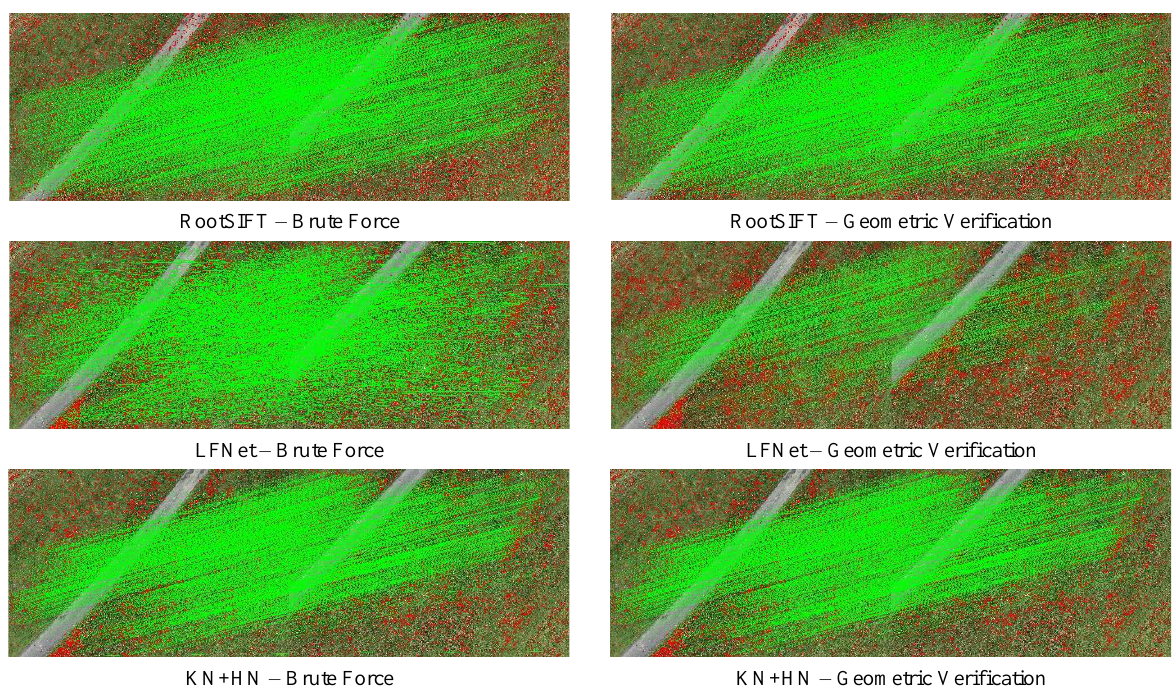
Figure 9. Image matching comparison before and after geometric